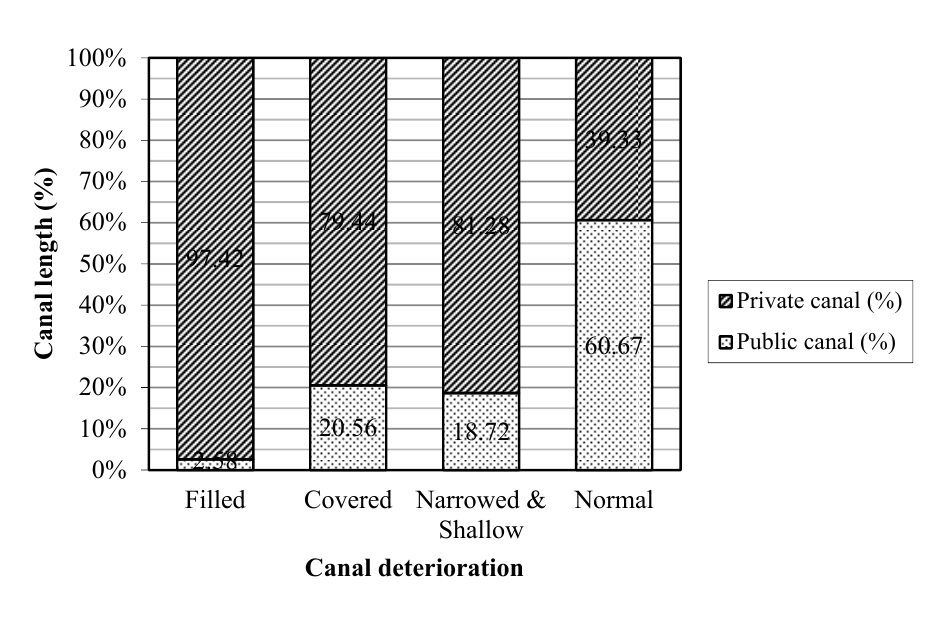
Figure 7. Percentage of canal deterioration in relationship to public-private ownership of canals.